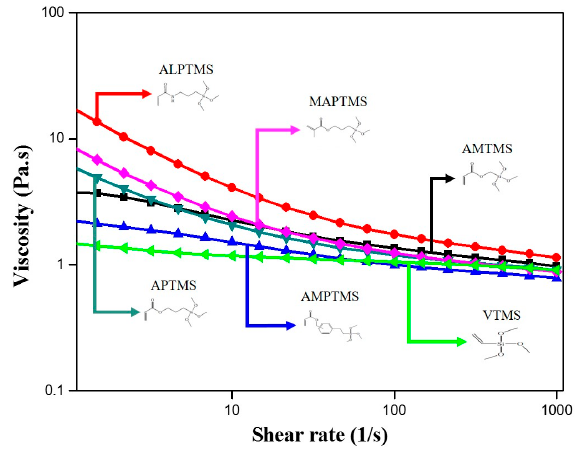
Figure 7. Viscosity curves of the SCA-coated Al 2 O 3 /High-temp composite solutions with different organofunctional groups.